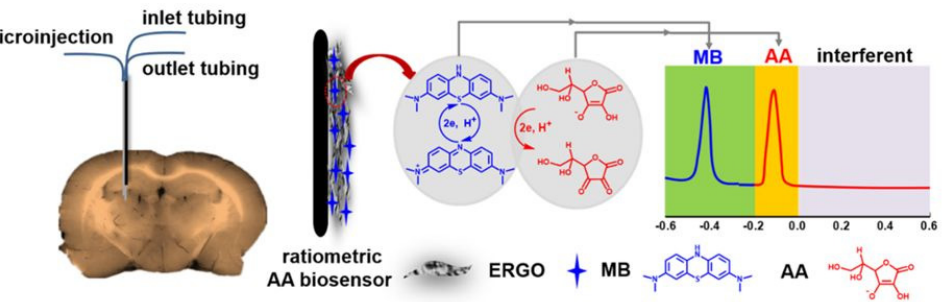
Figure 6. Schematic illustration of in vivo microinjection and the designed RECS for selective measurement of cerebral AA in brain microdialysate. Reproduced with permission from [37]. Copyright 2020 American Chemical